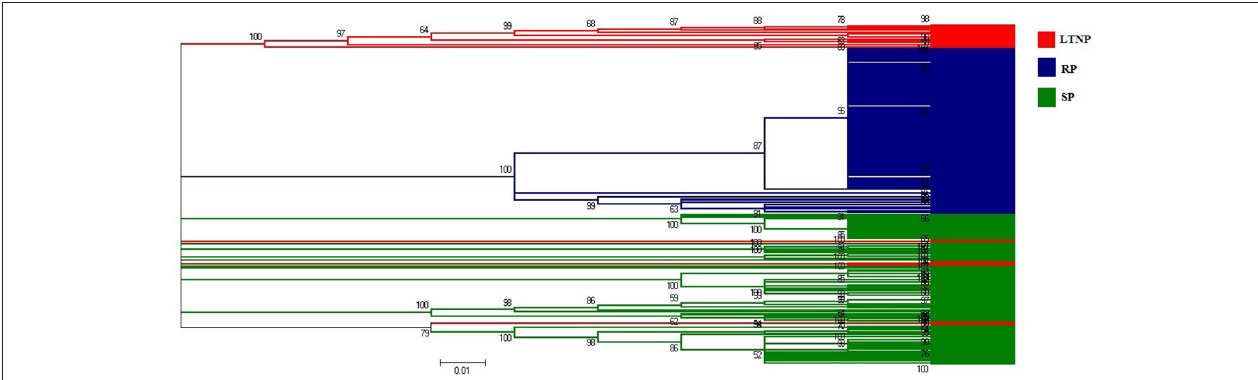
FIGURE 1 | Neighbor-joining method based phylogenetic tree of the env genes (LTNP, SP, and RP). Red colored lines represent Long term non-progressor (LTNP) sequences. Blue colored lines refer to the Rapid progressor (RP) sets. Green colored lines depict the Slow progressor (SP) sequences.